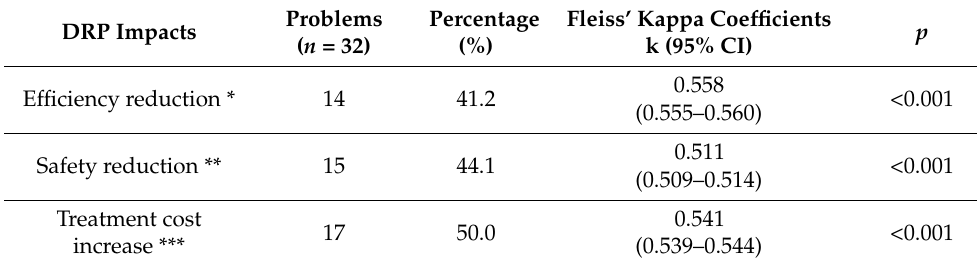
Table 4. Consensus of experts on the impact of the